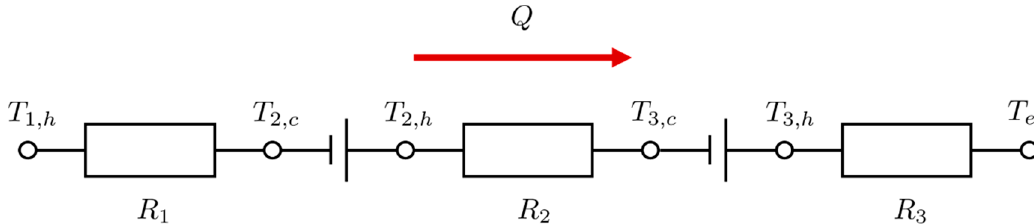
Figure 2. Heat current model of the heat transfer system (HTS).